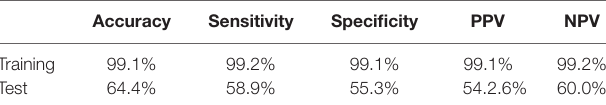
FigUre 6 | Sensitivity and specificity as a function of cutoff, the likelihood a state has a nodule. TaBle 2 | The sensitivity, specificity, accuracy, positive predictive value (PPV), and negative predictive value (NPV) PPV results are listed for our reinforcement model from training and from testing.